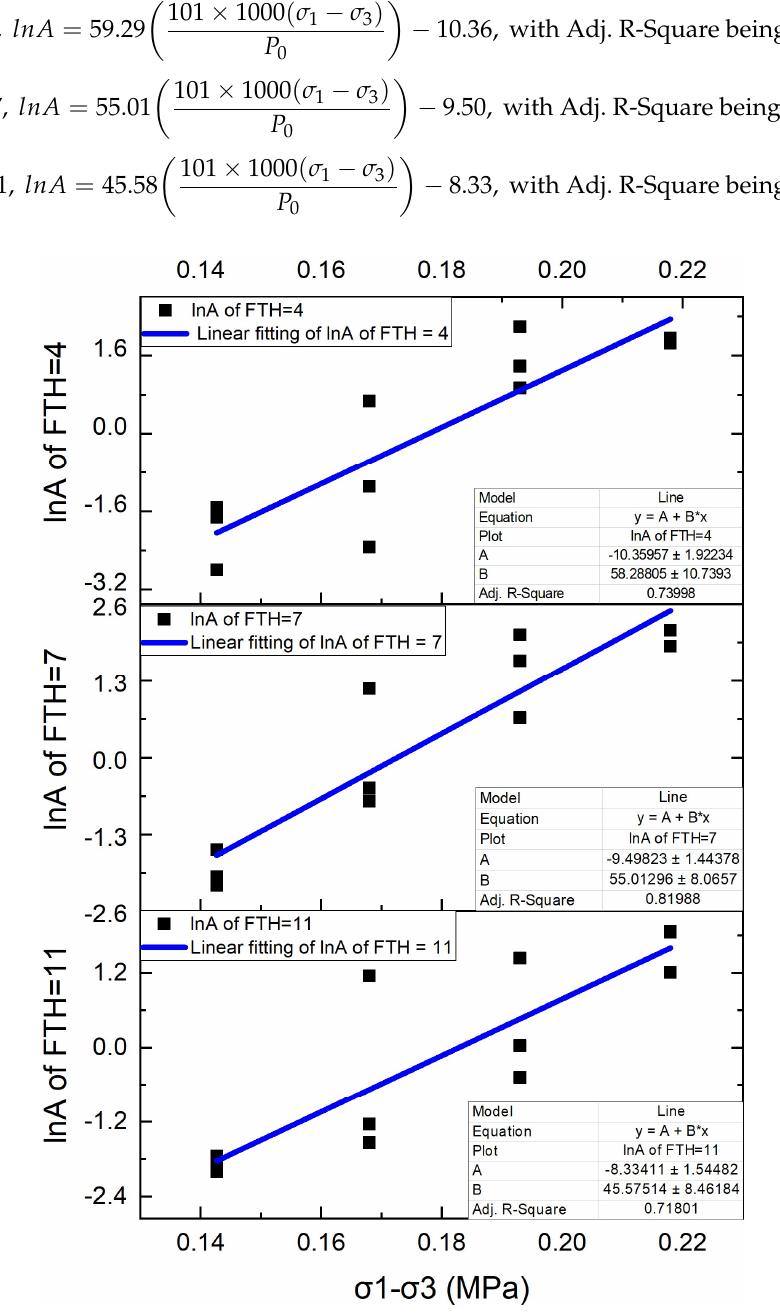
Figure 35. The correlations between A and high-level ADS > 0.14268 MPa under different FTHs. To present the effect of FTHs, the correlation among k , b and FTH is fitted and shows a linear characteristic, as shown in Figure